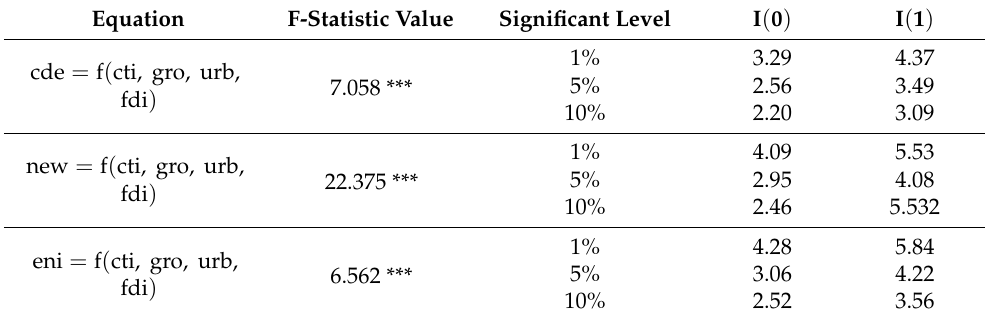
Table 3. Results of cointegration